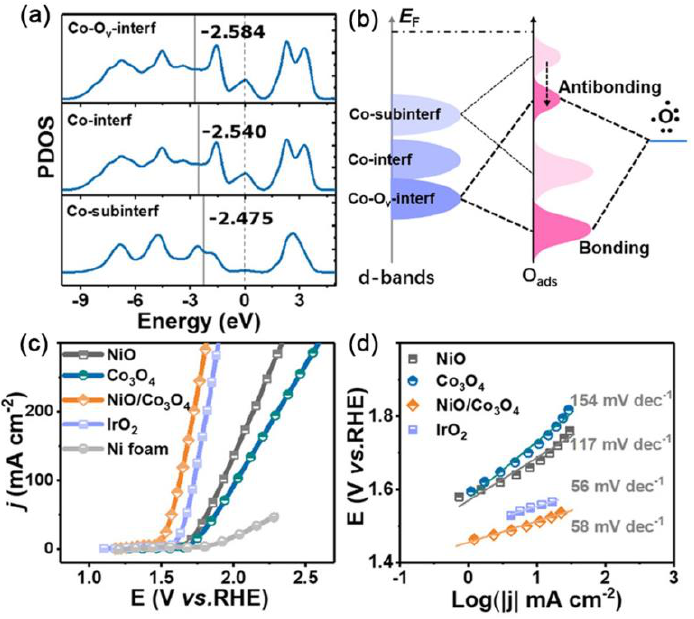
Figure 14. ( a ) PDOS of Co − 3d bands at different positions. ( b ) Schematic bond formation of atomic oxygen on shifting down d-band centers of Co. ( c ) Polarization curves after i R − correction, commercial IrO 2 and Ni foam were used for comparison. ( d ) Corresponding Tafel slopes obtained from polarization curves [122]. Copyright 2020, American Chemical Society.